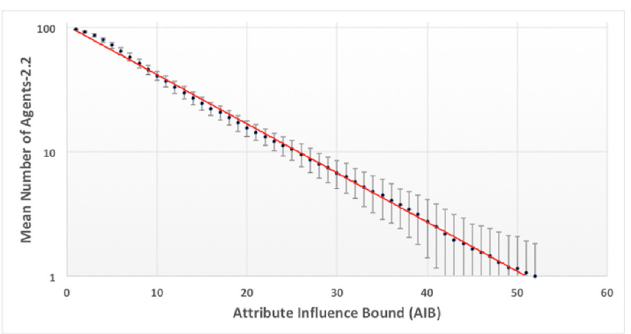
Fig 14. Ln(Mean number of agents—2.2) versus AIB, black points with standard deviation are data and red is a linear fit. Standard Conditions. Illustrates the exponential decrease in the number of final agents from 98.6 to 3.2 as AIB increases from 1 to 52.